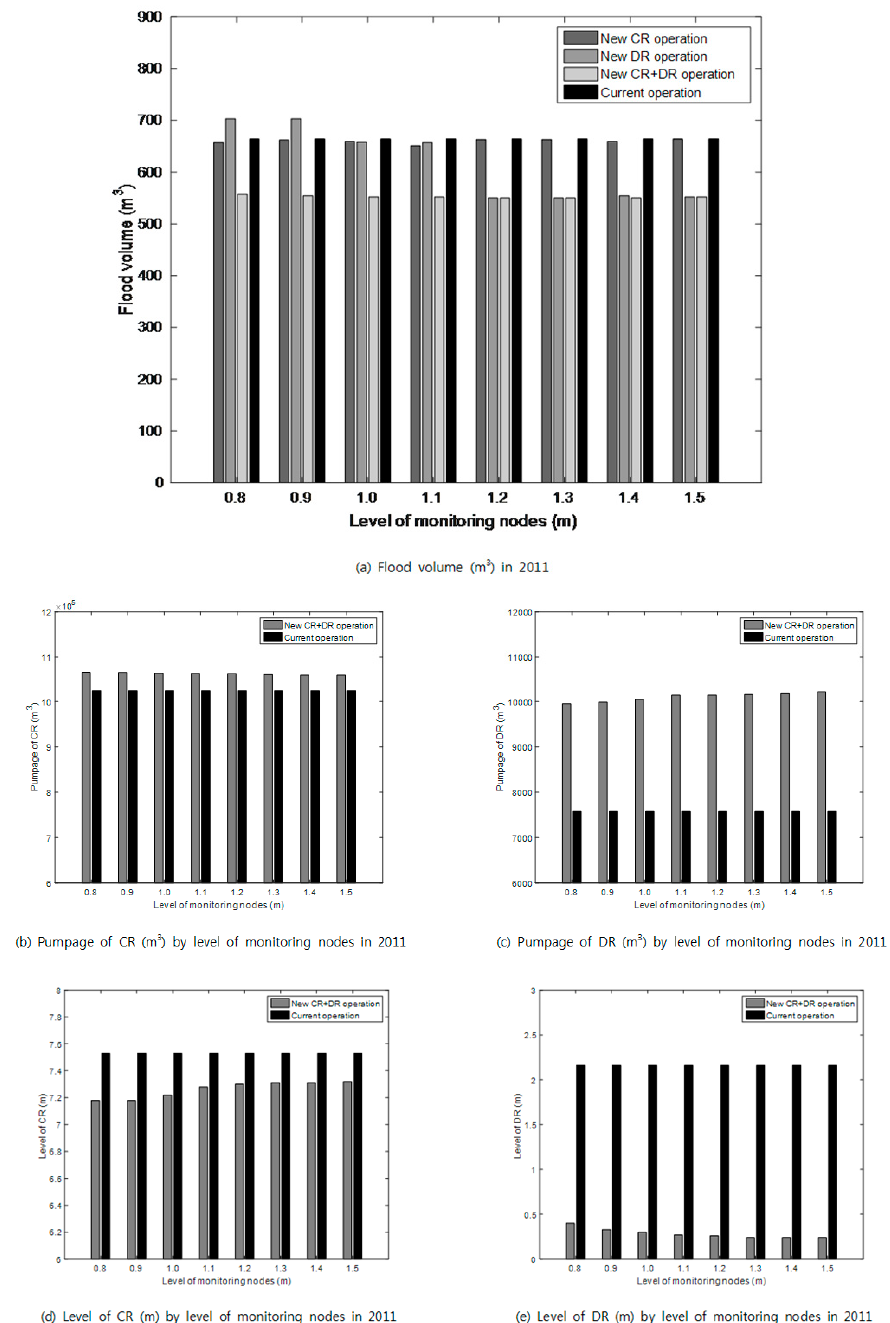
Figure 15. Results of cooperative operation in 2011.